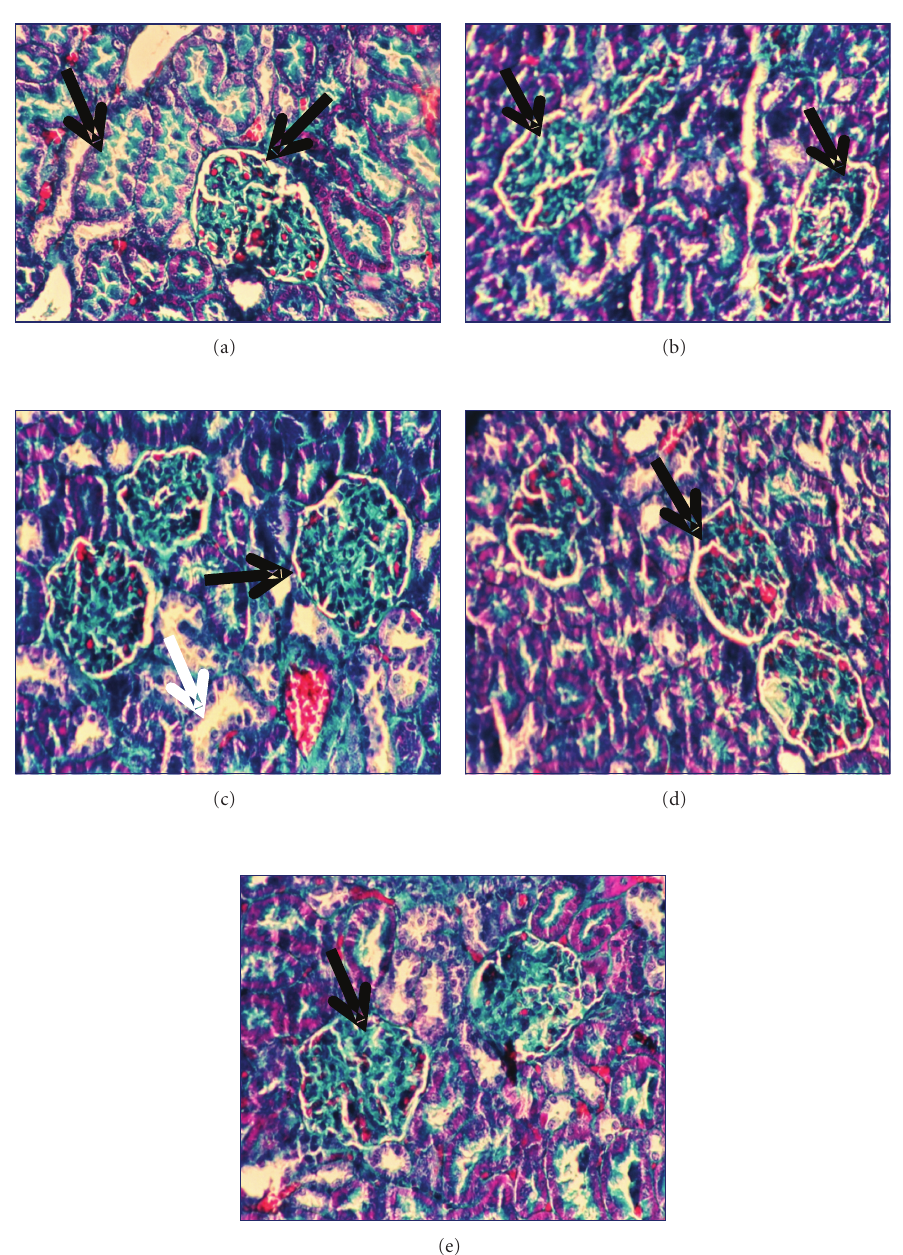
Figure 5: Photomicrography of kidney sections (200x) of control (a), control treated with ethanol extract (b), control treated with chloroform extract (c), control treated with petroleum ether extract (d), and control treated with silymarin (e) stained with Masson’s